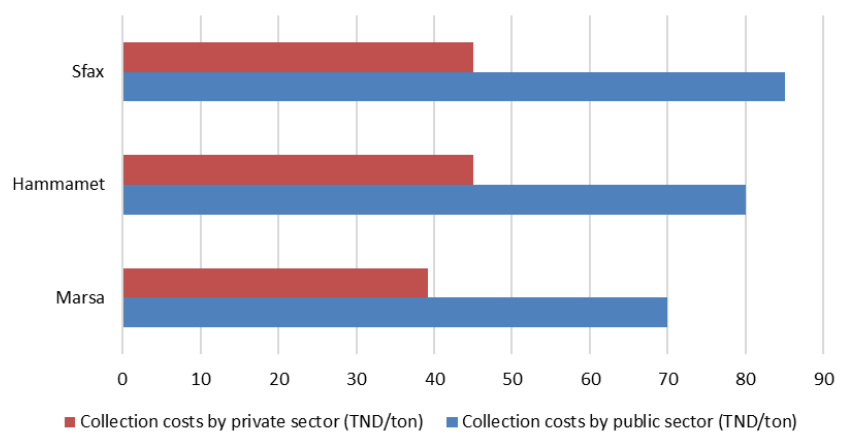
Figure 10. Comparison between SW collection costs from hotels by the private and public sectors.